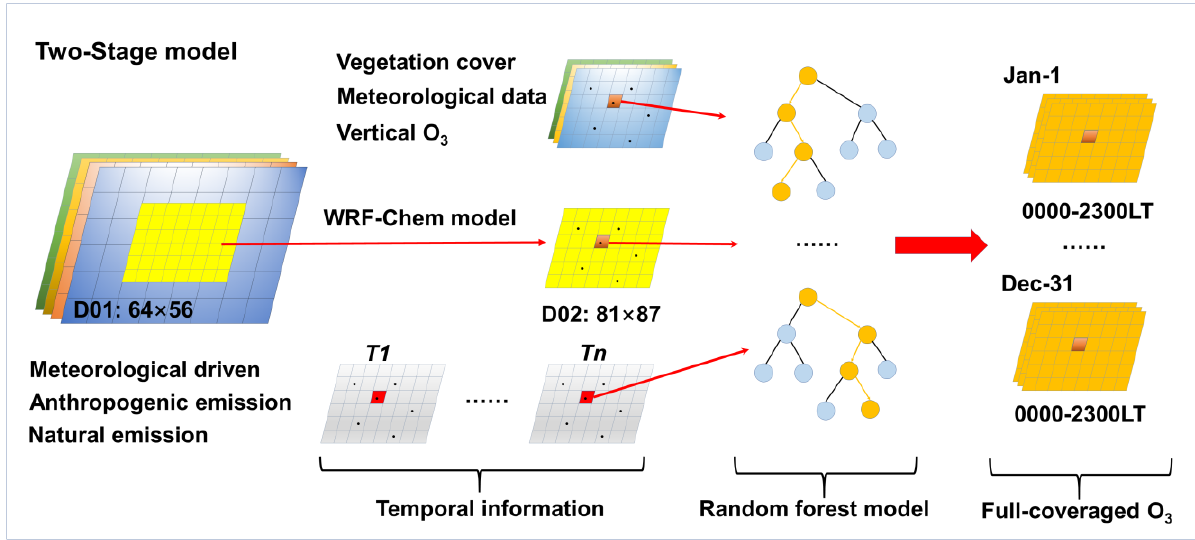
Figure 1. Flowchart of the two-stage model.